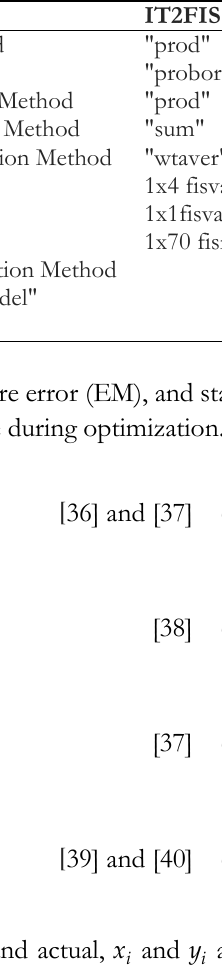
Table 2. Parameters of the PSO and IT2FIS.